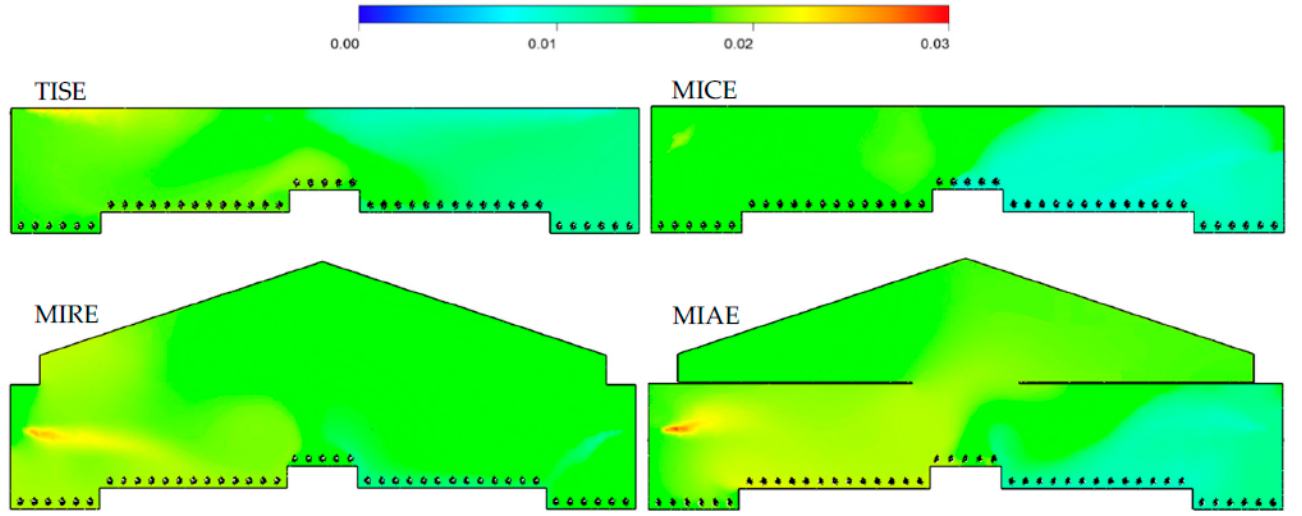
Figure 6. Indoor mass fraction contours of virus particles in the four models (TISE, MICE, MIRE, and MIAE) at the cross-sectional reference plane, CP-N.